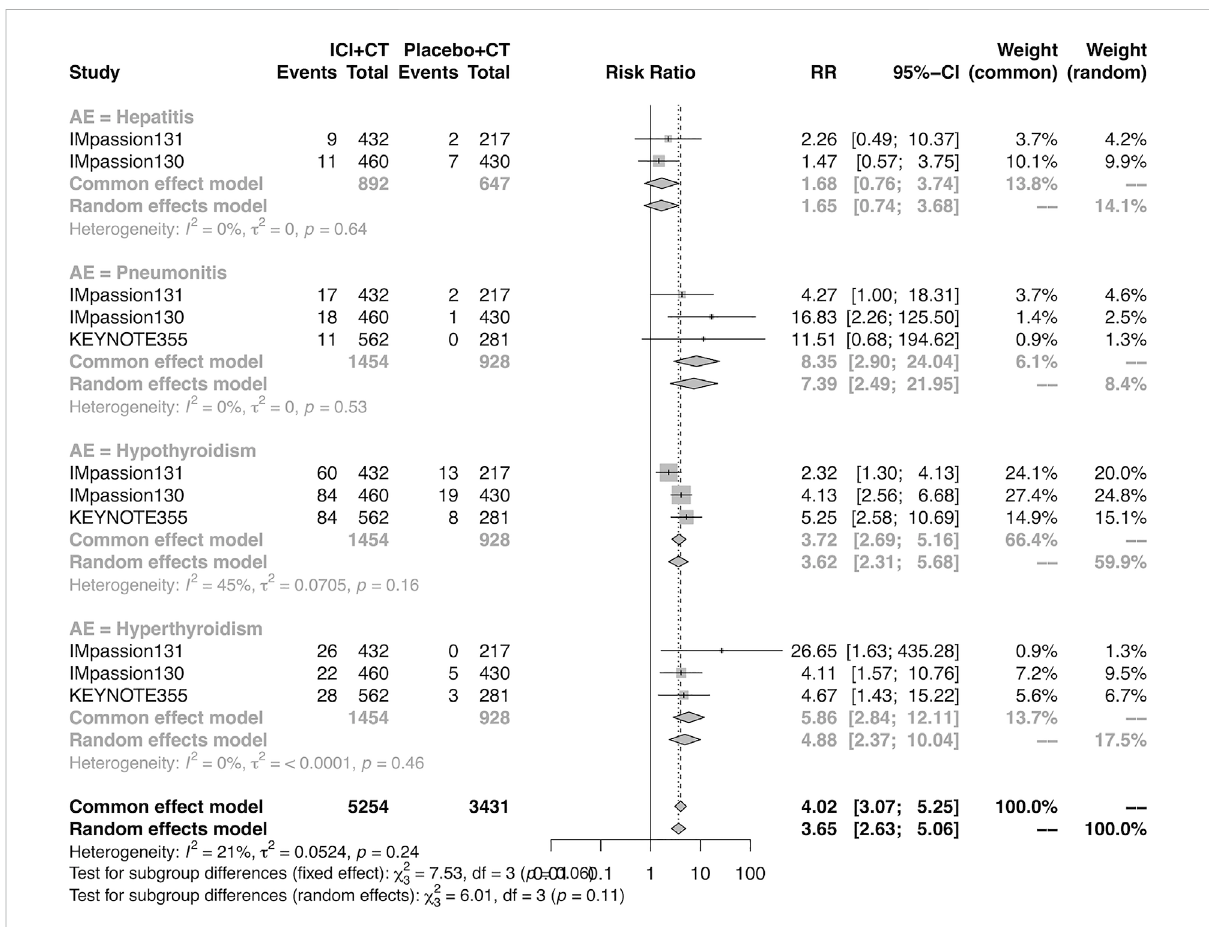
FIGURE 8 Pooled speci fi c AEs in any grade in adjuvant therapy clinical trials. AEs, adverse events; RR, relative risk; 95% CI, 95% con fi dence interval; ICIs, immune checkpoint inhibitors; CT,